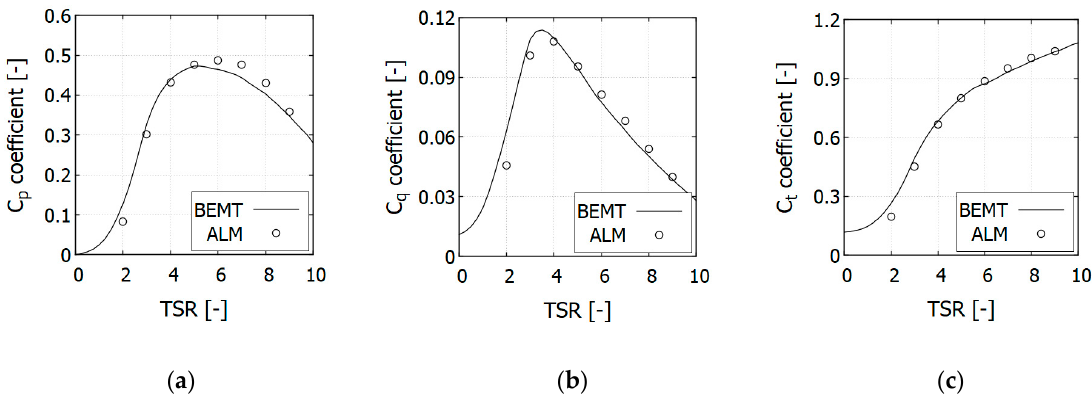
Figure 3. C p ( a ), C q ( b ) and C t ( c ) coefficients obtained with Blade Element Momentum Theory (BEMT) and Actuator Line Model (ALM).